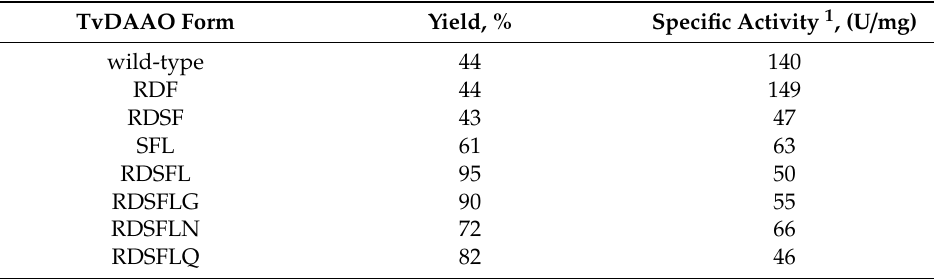
Table 1. Purification of wild-type and mutant TvDAAOs.